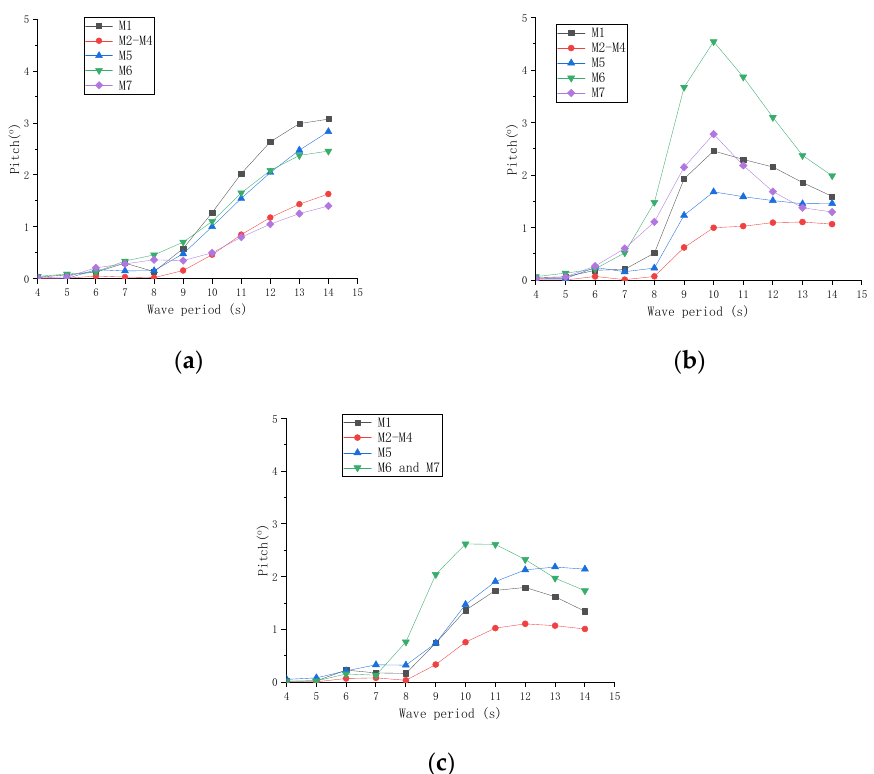
Figure 11. Pitch responses of three expansion scheme: ( a ) Scheme A; ( b ) Scheme B; ( c ) Scheme C. The surge responses of the three expanded MIFS systems are shown in Figure 9. Three representative modules (M2, M5 and M6) are selected as the objects. Compared the Figure 9a with the Figure 7a, it indicates that the expansion Scheme A can effectively reduce the surge responses of the original MIFS system for wave period less than 11 s, which is due to the shield effect of more up-wave modules. However, it tends to result in larger surge for the wave period larger than 12 s, that is because the modules’ shield ef- fect decreasing with the increase of the wavelength, as well as more modules inducing more wave loads. Compared Figure 9b with Figure 7a, it can be seen that the surge trend of the ex- pansion Scheme B is similar to the original MIFS system, while the surge responses of the